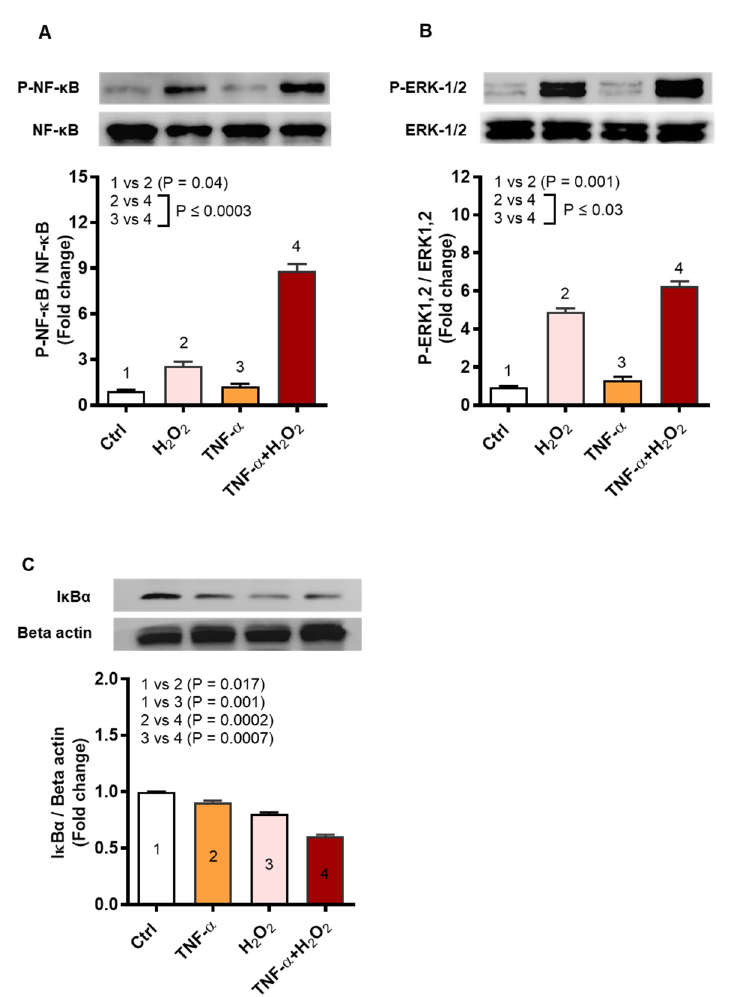
Figure 8. TNF- α /H 2 O 2 cooperativity drives IL-8 and MCP-1 expression via activation of the NF- κ B and ERK-1/2 mediated signaling. THP-1 monocytic cells were stimulated, in triplicate, with TNF- α (10 ng/mL) for 10 min and/or H 2 O 2 (10 mM) for 30 min. Cell lysates were resolved by 12% SDS- PAGE and blots were probed with primary and secondary antibodies for detection of phosphorylated and total NF- κ B (65 KDa) and ERK1/2 (42, 44 KDa), as well as for detection of total I κ B α (36 KDa) and beta-actin (45 KDa). One-way ANOVA (Tukey’s multiple comparisons test) was used to calculate group differences and p -values less than 0.05 were considered as significant. Representative band densitometry data (mean ± SEM) from three independent experiments with similar results, following normalization show increased phosphorylation of ( A ) NF- κ B ( p ≤ 0.0003) and ( B ) ERK1/2 ( p ≤ 0.03) as well as degradation of ( C ) I κ B α ( p ≤ 0.0007) in the cells co-stimulated with TNF- α and H 2 O 2 as compared to those stimulated with TNF ‐α or H 2 O 2 alone.